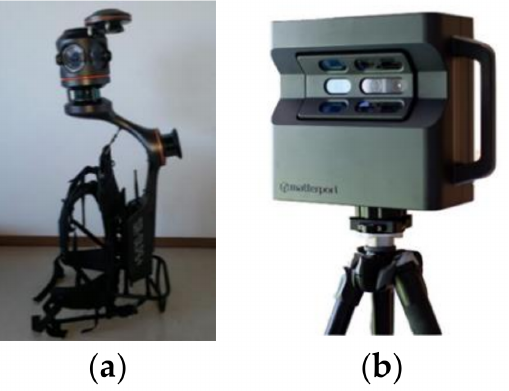
Figure 3. Collection equipment of the point cloud scene. ( a ) Backpack mobile surveying and mapping robots and ( b ) Matterport